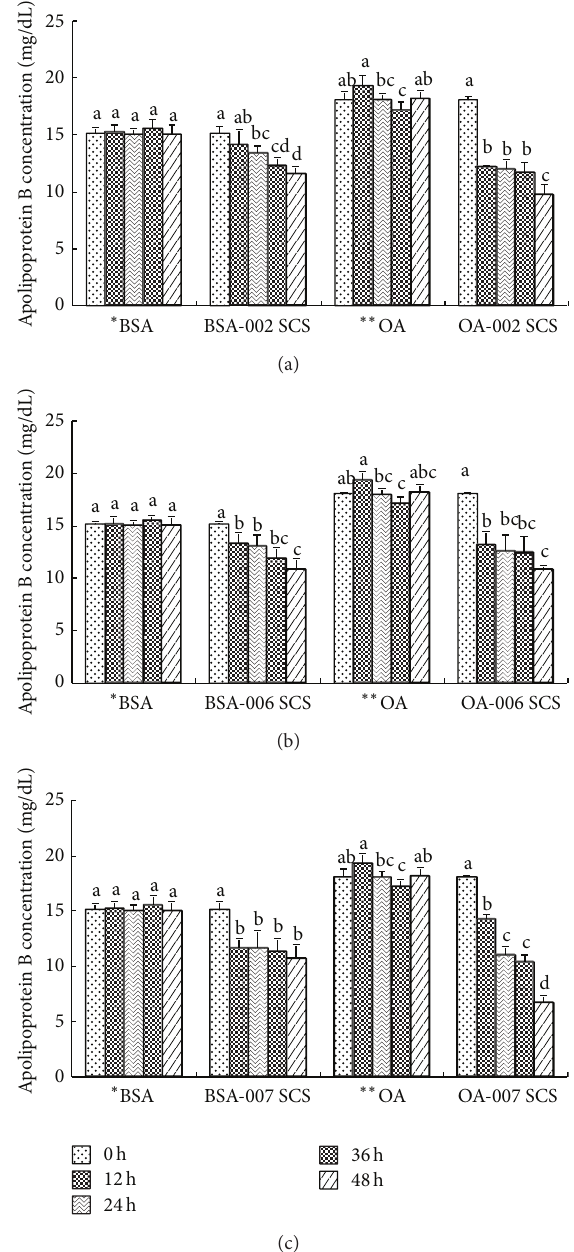
Figure5:InhibitionofapoBinHepG2cellswhichweretreatedwith the suspension of the LAB strains (a) NBHK002, (b) NBHK006, and (c) NBHK007. a , b , c , d Means with different superscript letters within the same culture are significant differences ( 𝑃 < 0.05 ) by Duncan’s multiple range test. ∗ BSA: bovine serum albumin; ∗∗ OA: oleic